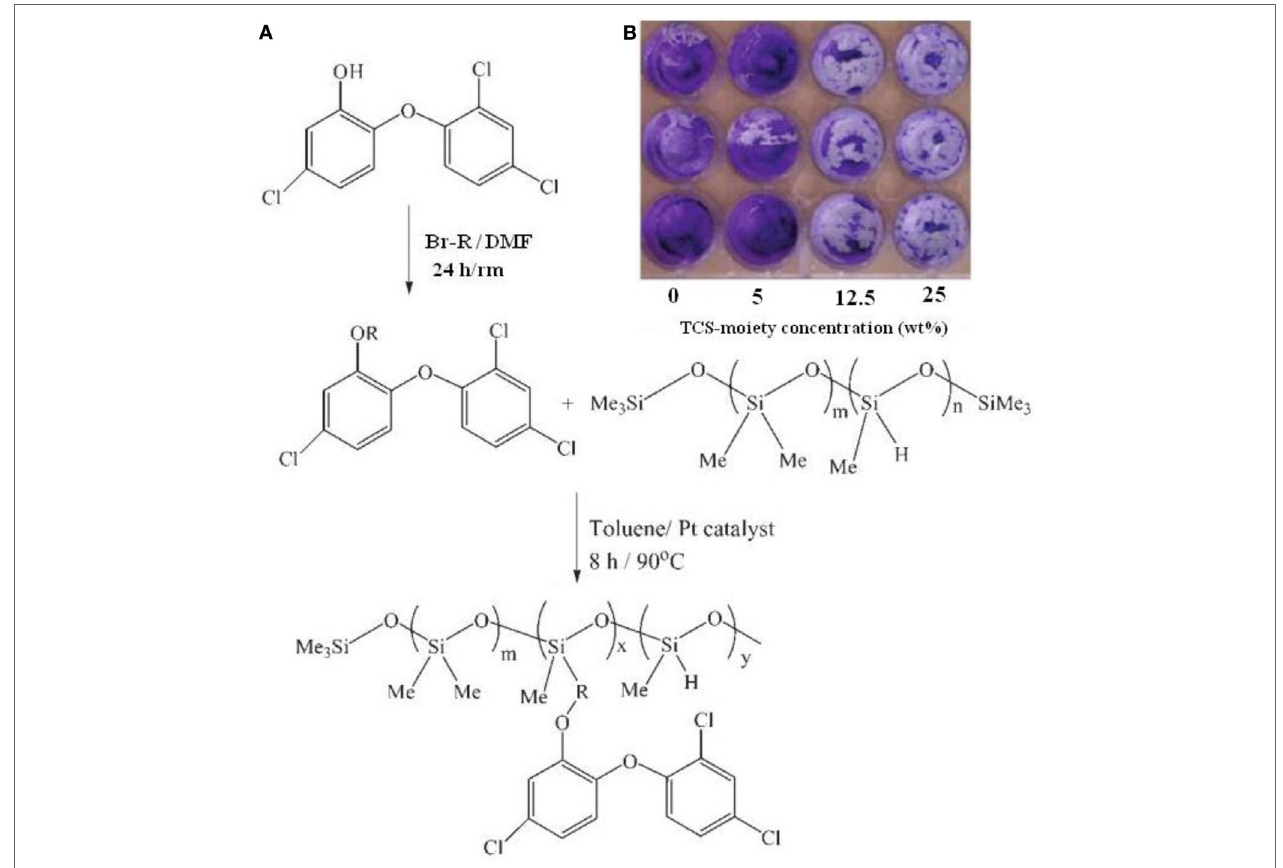
FiGURe 1 | (A) Process of the modification of trisolan biocide and the incorporation of modified biocide intosiloxane, (B) images of C. lytica biofilm coverage after crystal violet staining on polydimethylsiloxan coatings containing TCS moieties. Reprinted with permission from Ye et al. (2008). Copyright 2008 American Chemical